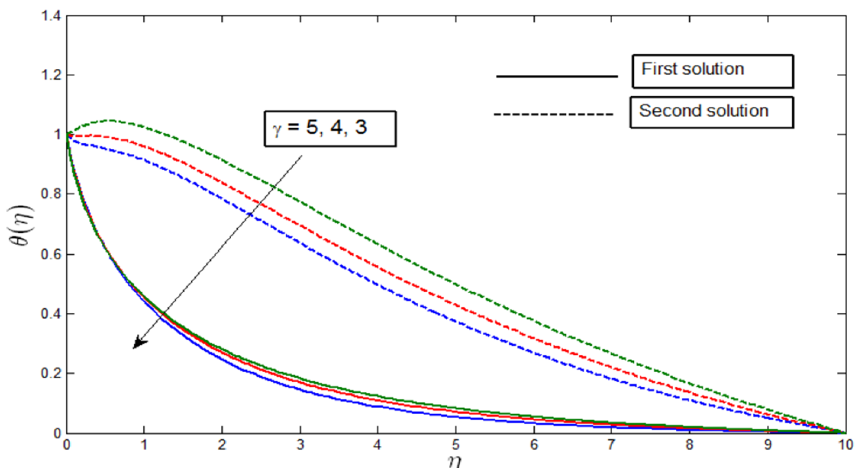
Figure 7. Temperature profile θ(η) for various γ when (cid:31) = − 4, Lb = 1, Le = 1, Pb = 1, Nr = 0.5, Rb = 0.6, A =